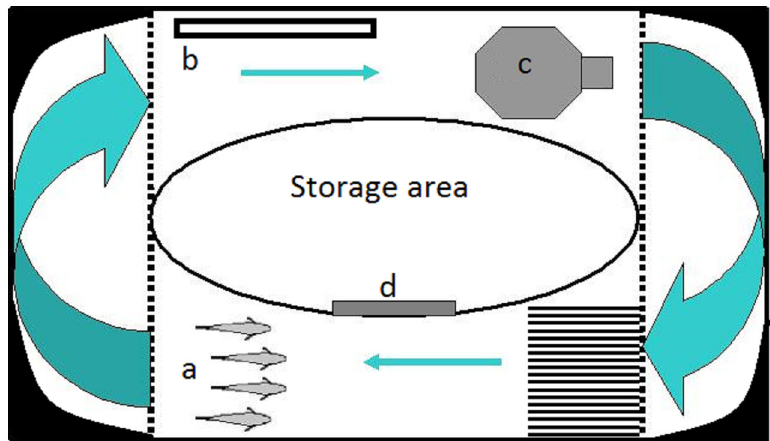
Figure 2. A diagram of the flume in which the preferred location of each fish within a school was tested. Arrows indicate the water flow and the broken lines indicate the mesh barriers confining subjects to the test area. The position of the (a) subjects, (b) heater, (c) pump and (d) trap door are